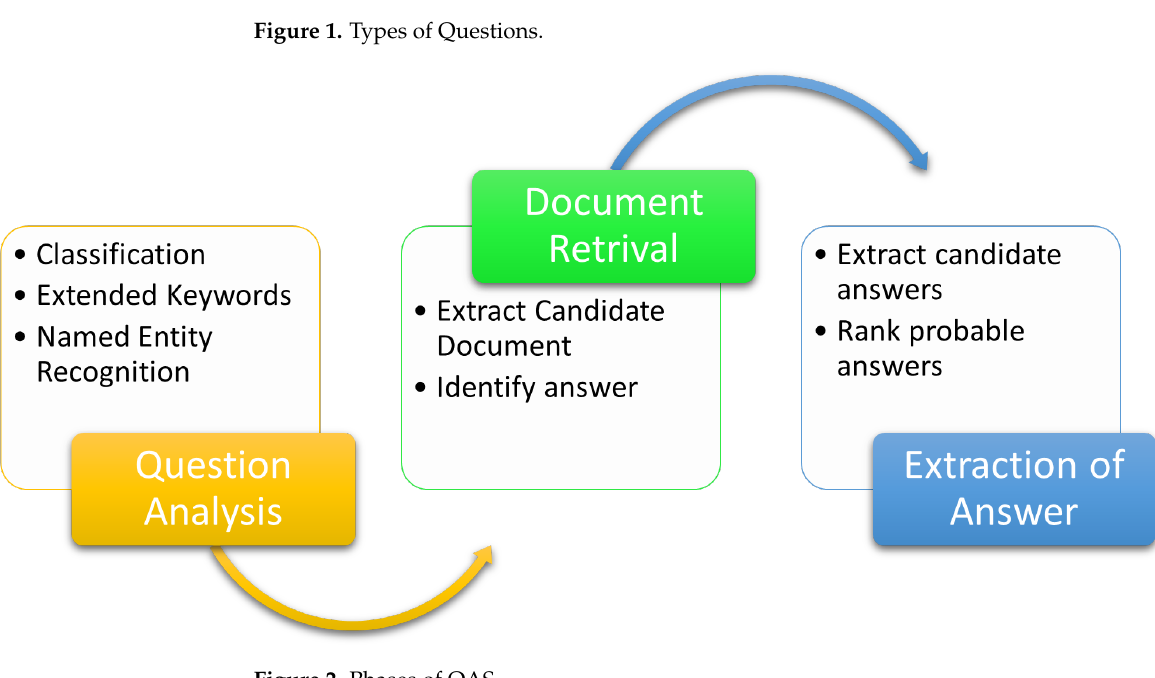
Figure 2. Phases of